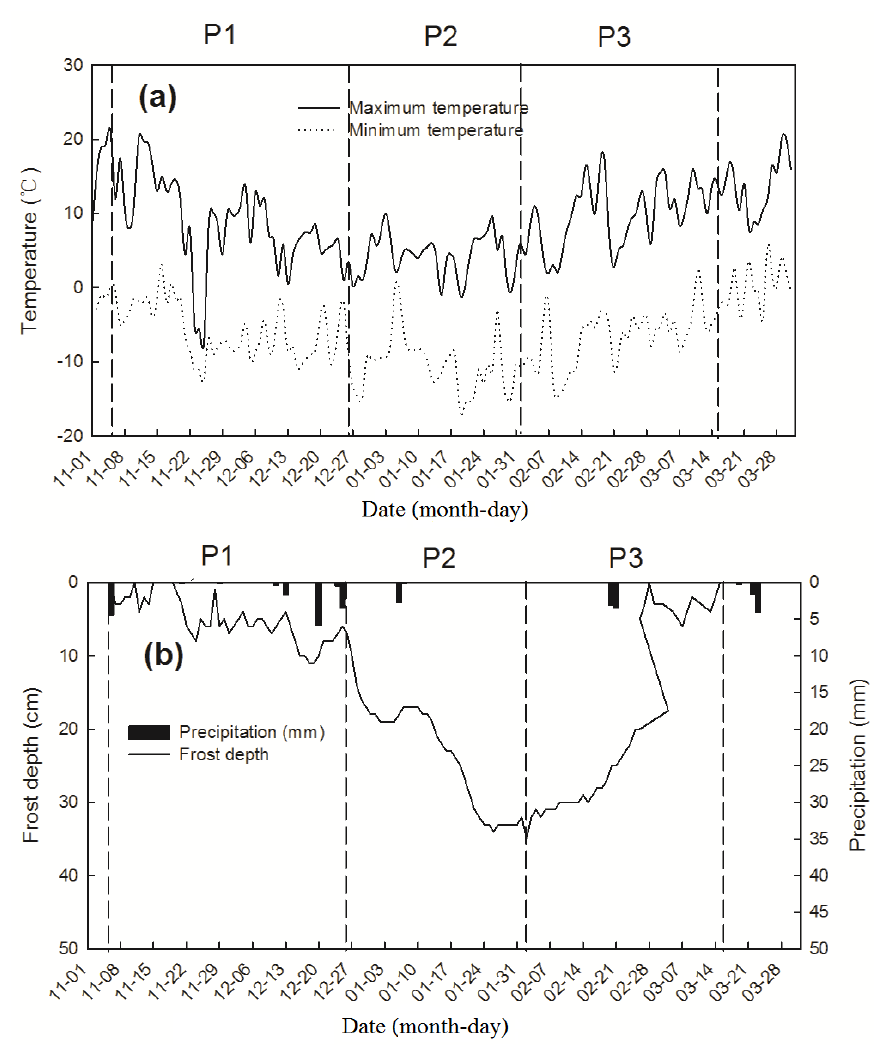
Figure 2. ( a ) Air temperature; ( b ) Precipitation and frost depth during the freeze–thaw